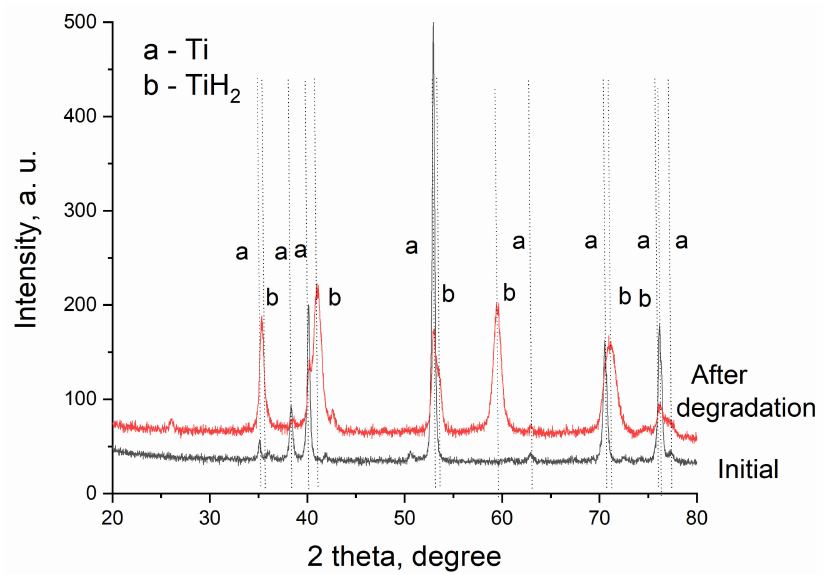
Figure 6. Grazing incidence X-ray diffraction (GIXRD) data of titanium plate and titanium plate sintered with Mg alloy after degradation of Mg